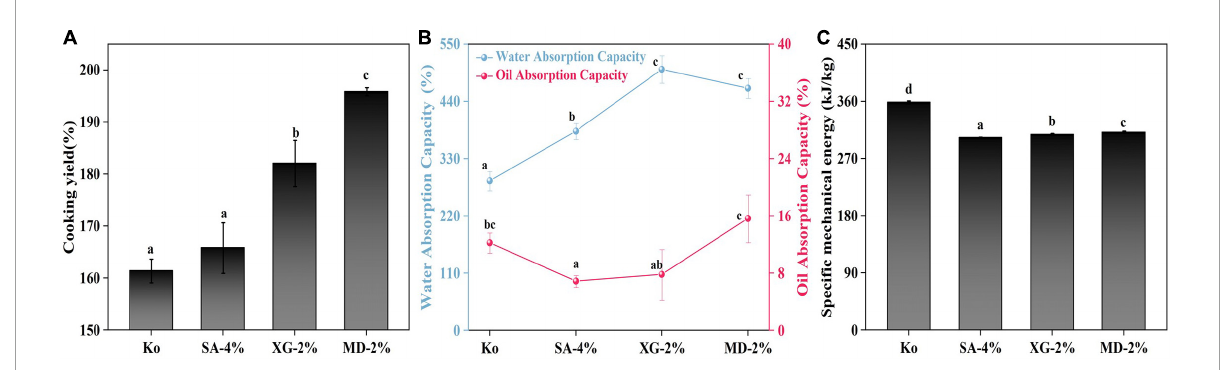
FIGURE2 Effect of different contents of sodium alginate (SA), xanthan gum (XG), and maltodextrin (MD) of the extrudates on the (A) Cooking yield, (B) Water absorption capacity and Oil absorption capacity, and (C) Specific mechanical energy. Different letters imply significant differences between different samples ( P <